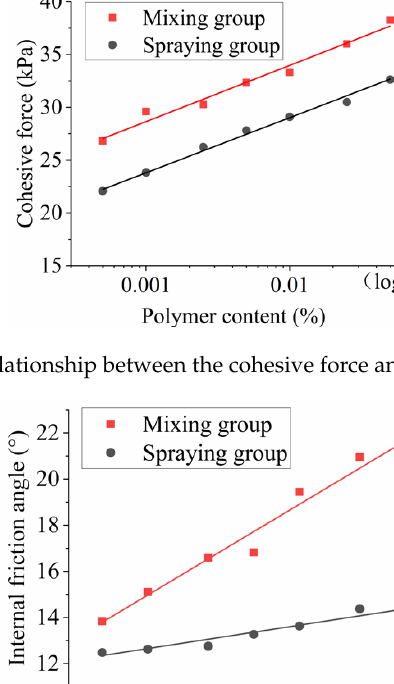
Figure 10. The relationship between the permeability coefficient and polymer content. Equations (2) – (5) describe the change trends of the average particle diameter, permeability coefficient, cohesive force, and internal friction angle after soil improvement. Most of the R values were close to 1, and thus the correlation as a result of data fitting is reliable. According to the Mohr – Coulomb principle, as shown in Equation (6), the shear strength of soil was determined by the cohesive force and internal friction angle. By substituting Equations (3) and (4) into Equation (6), the shear strength growth model of the soil mass after improvement could be obtained, as shown in Equation (7).